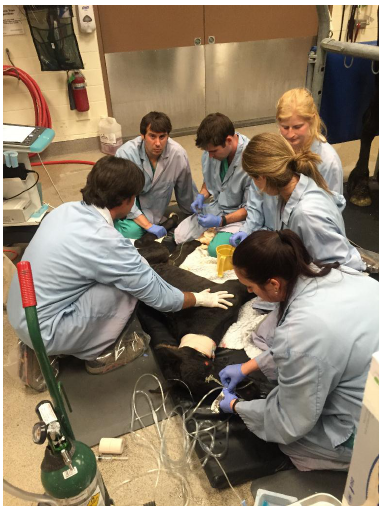
Figure 1. Neonatal foal being received and evaluated in an intensive care referral veterinary hospital. NMS foals may need a controlled environment with minimal pathogens and ideal temperature, often